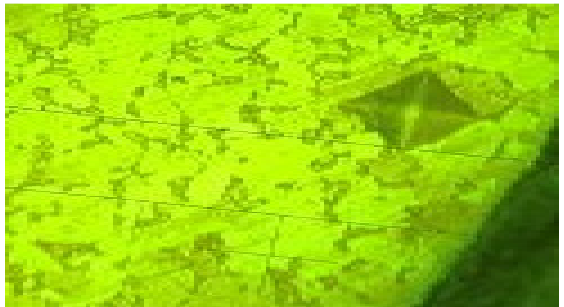
Fig. 1. Microstructure of penetration for the carburized sample